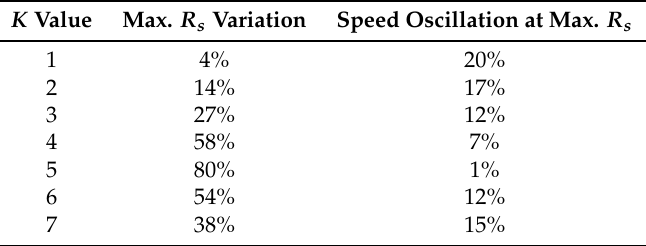
Table A2. K gain selection